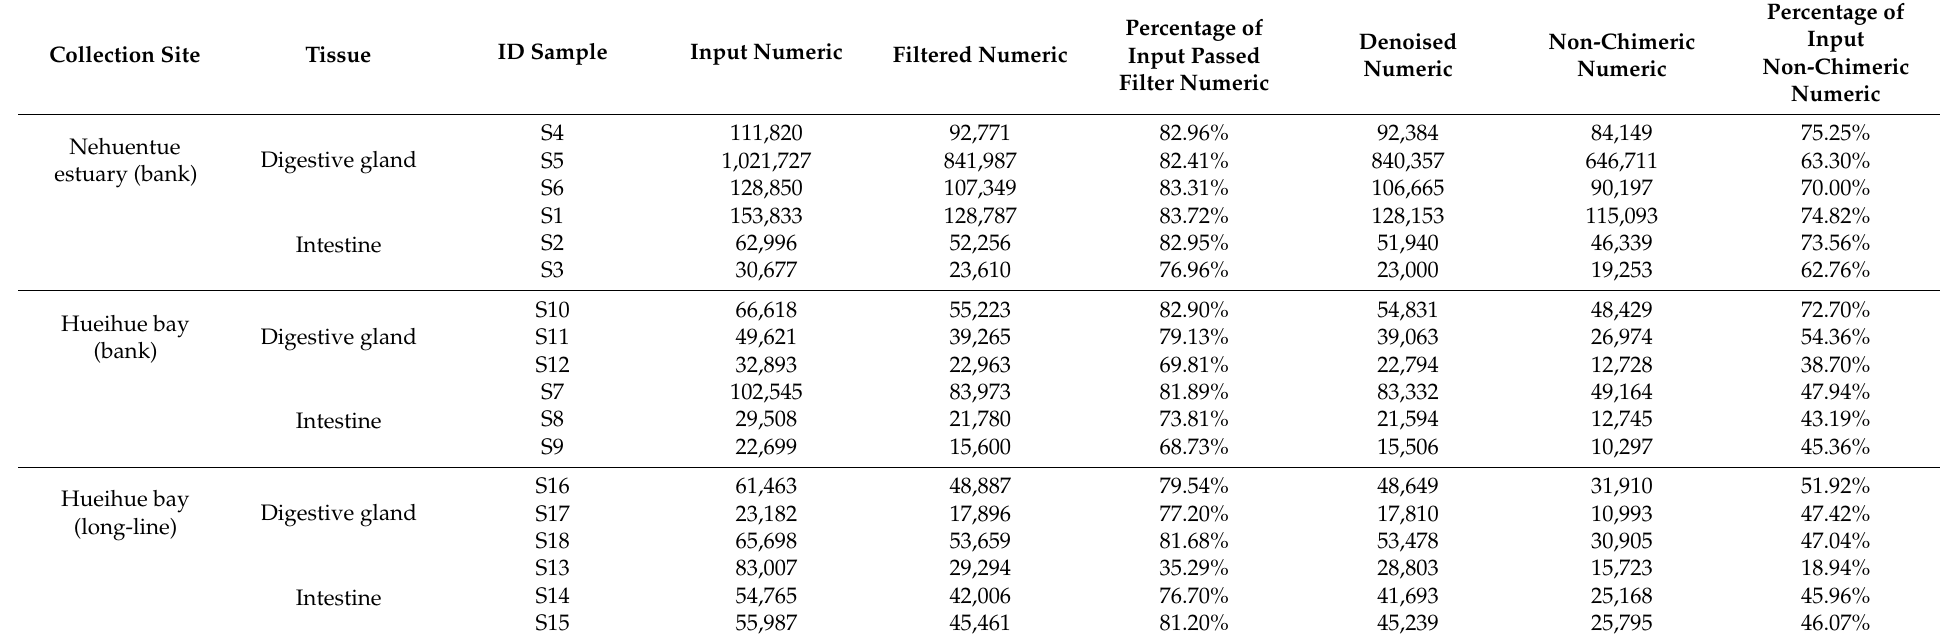
Table 2. Summary of Illumina sequencing